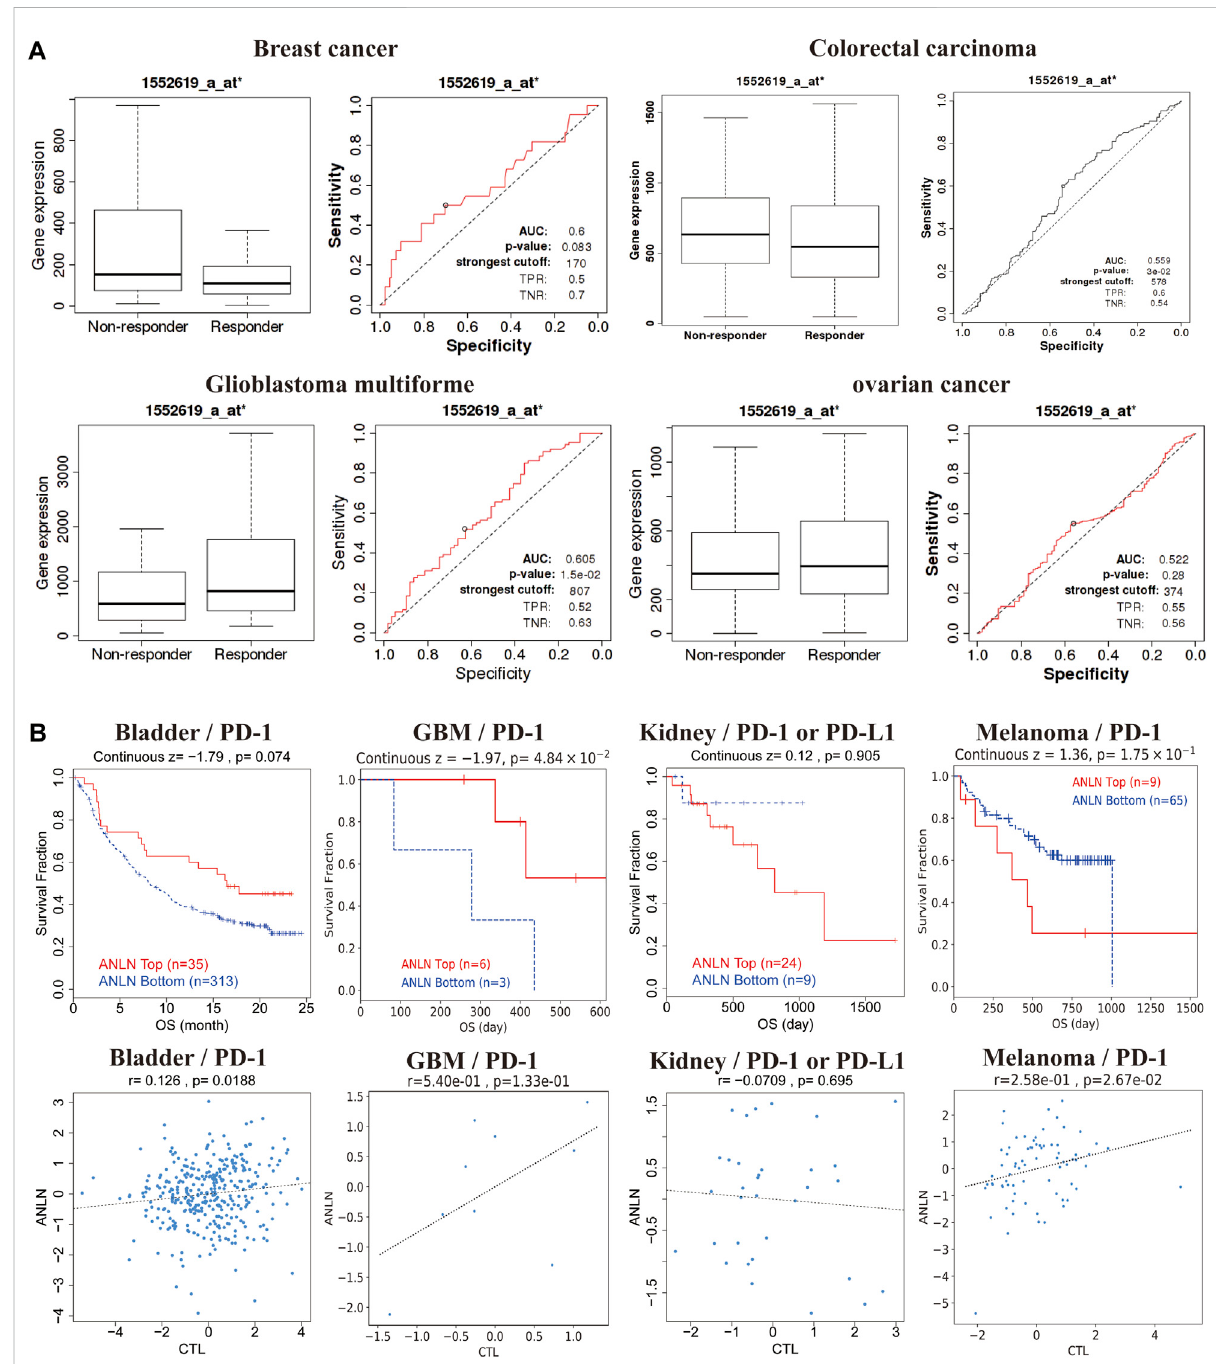
FIGURE 8 ANLN expression correlates with treatment response in multiple cancer types. (A) ROC plot of the association between ANLN expression and chemotherapy response in breast, brain, colorectal, and ovarian cancer cohorts. (B) Kaplan-Meier curves (upper panel) as a measure of immunotherapy response between cancer cohorts with high and low ANLN expression. The graph below shows the correlation between ANLN expression and cytotoxic T-cell